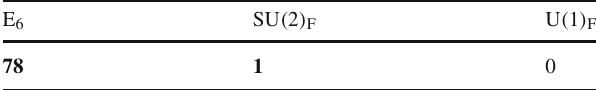
Table 9 Gauge superfields present between M 8 and M 6